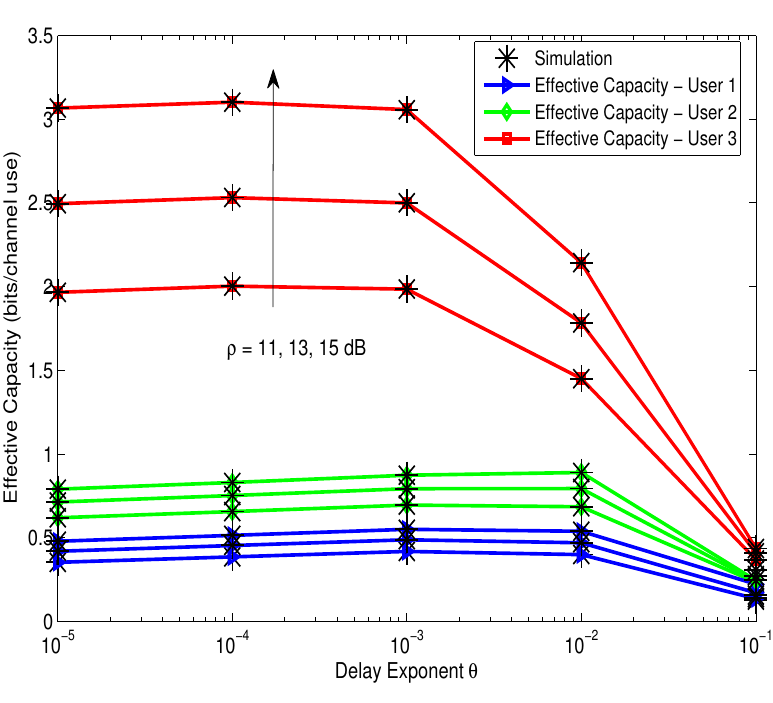
Figure 5. Effective capacity vs. the delay exponent θ , with n = 300, ε = 10 − 5 . Figure 6 plots the effective capacities of the three users vs. the SNR and